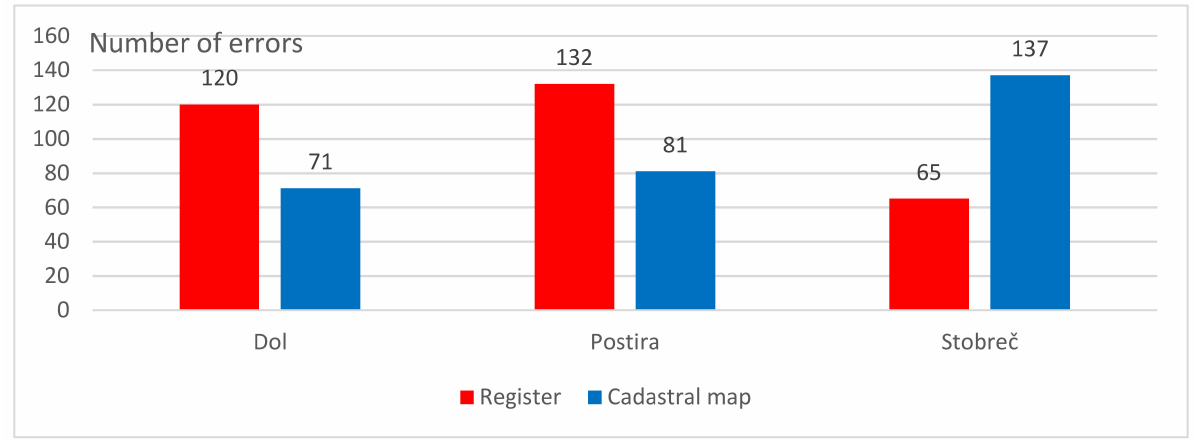
Figure 5. Documents containing resolved inconsistencies. Source: own